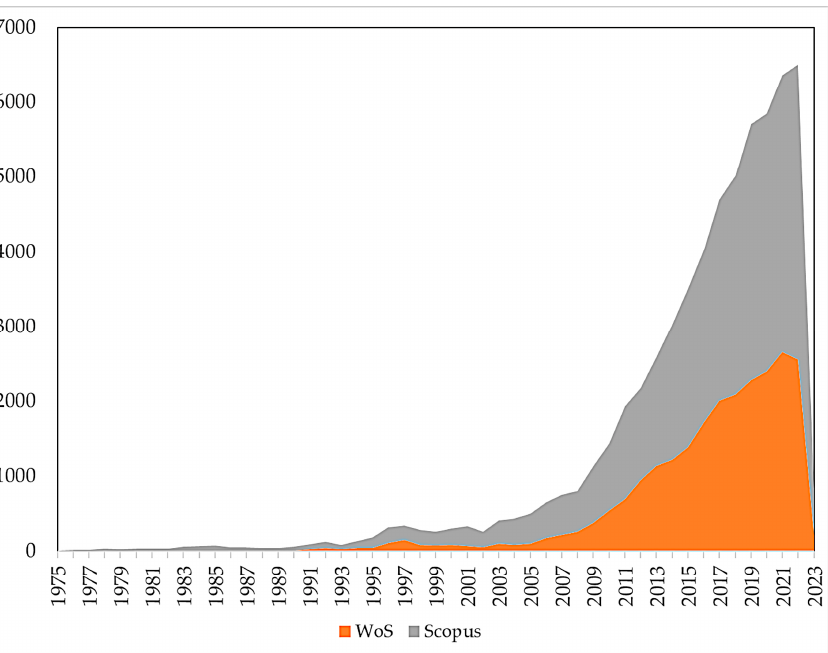
Figure 5. Number of articles published annually using first query. Source: Own elaboration.